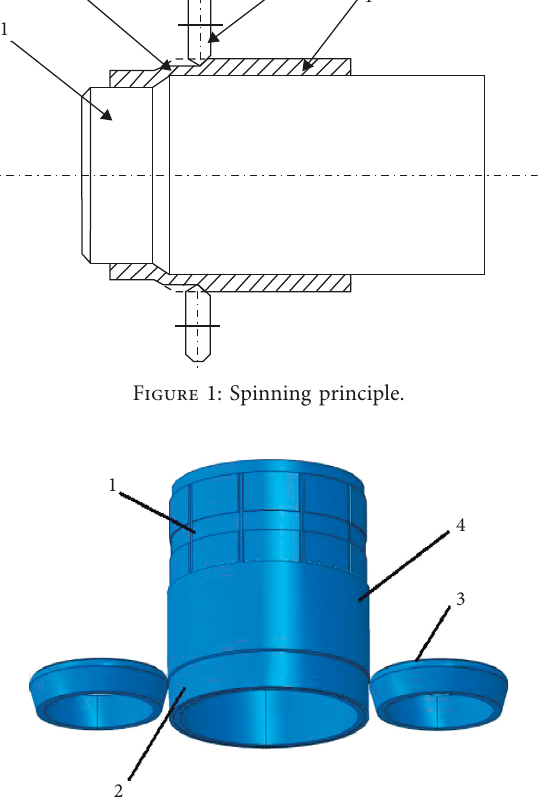
Figure 2: Simulation